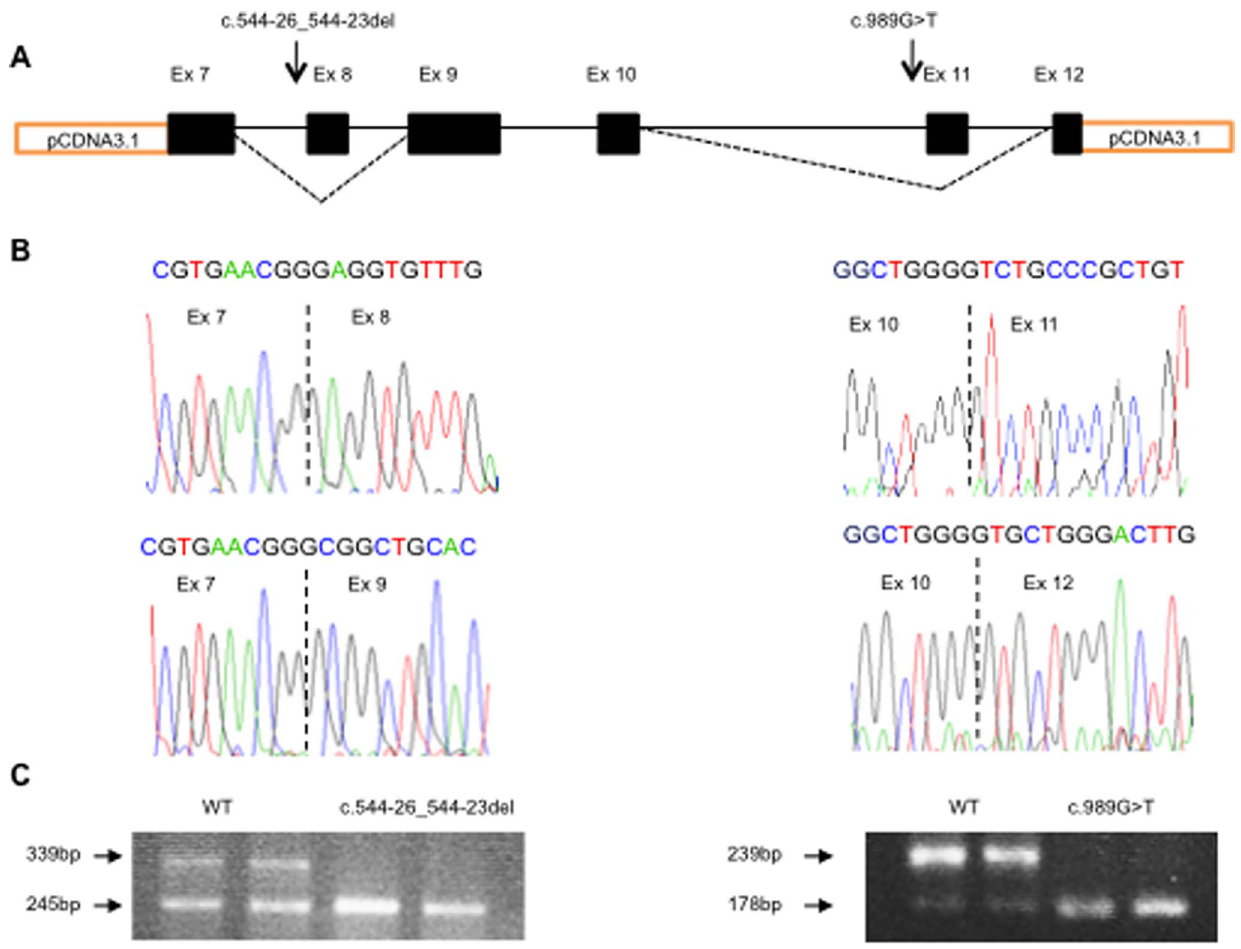
Figure 3. Functional analysis. Results of functional studies of two putative PTH1R splice mutations by minigene reporter analysis. (A) Schematic location of the two putative splice mutations and the observed exon skipping, indicated by dotted lines. The two mutations are for graphical reasons depicted on the same figure, but are obviously located on separate constructs (B). Sequencing results of normal cDNA minigene transcript and of cDNA from the c.544-26_544-23 (ID: F3) and c.989G . T (ID: F1) minigene transcripts, demonstrating complete skipping of exon 8 and exon 11, respectively. (C) Both normal and irregular splicing is observed for the normal allele in both analyses indicating that native exon 8 and 11 have weak 3 9 -splice sites. The putative branch point mutation c.544-26_544-23 results in complete skipping of exon 8 whereas the c.989G . T splice site mutation results in complete skipping of exon 11.